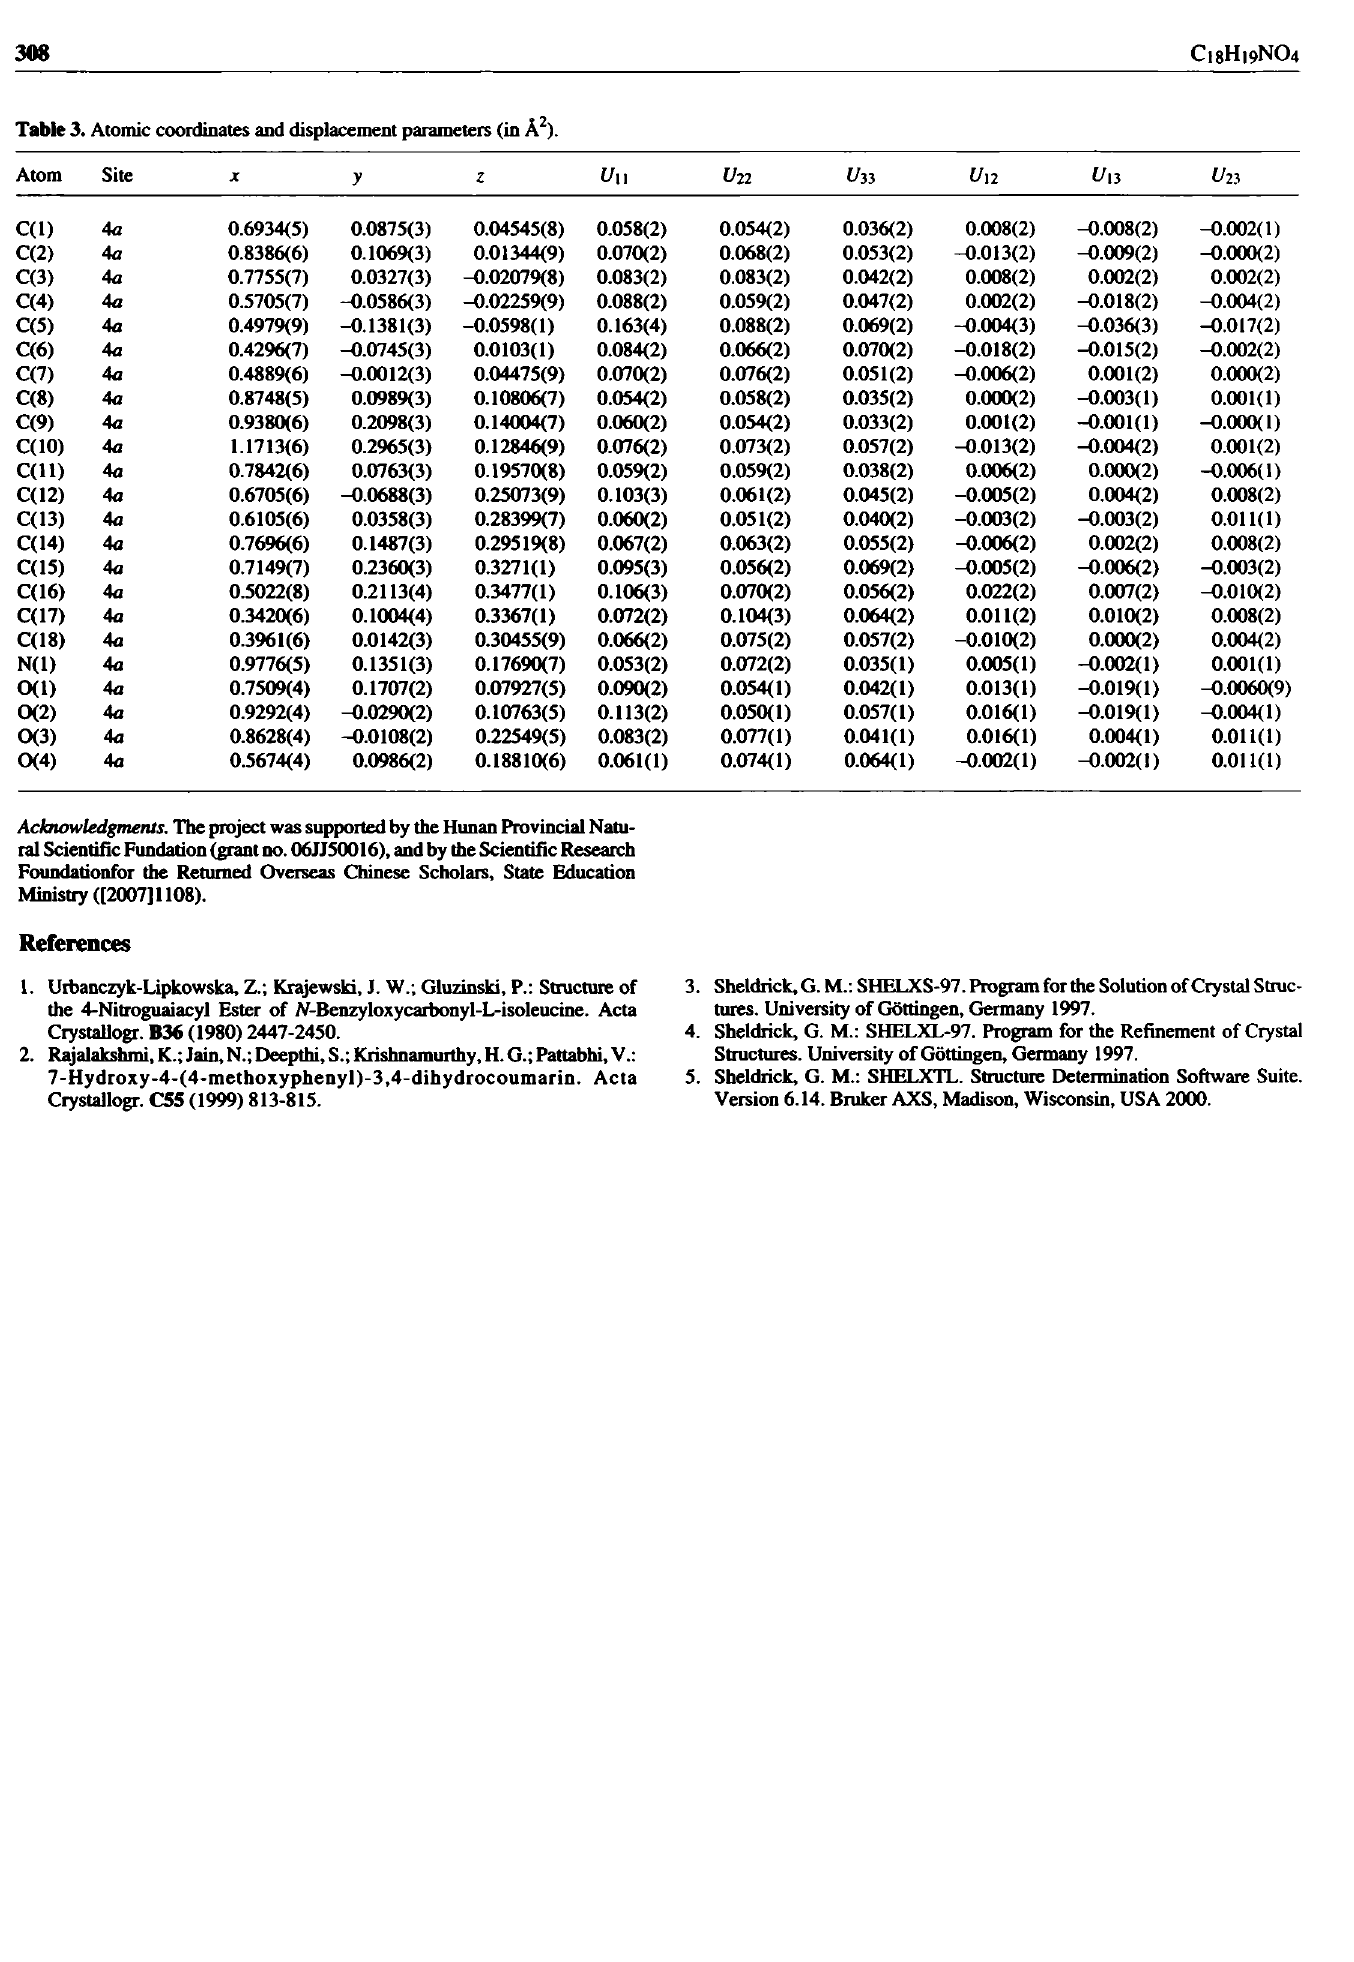
Table 3. Atomic coordinates and displacement parameters (in Â 2